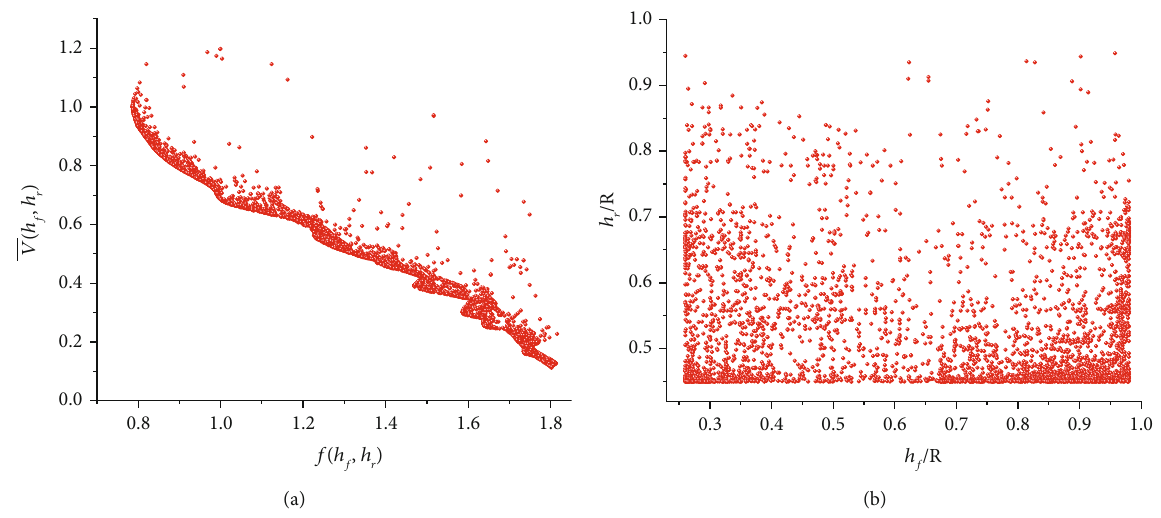
Figure 6: Diagram of optimization results based on NCGA-II